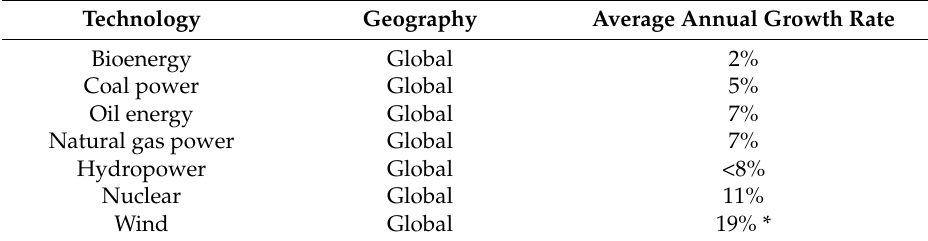
Table 7. Historical growth rates for established energy technologies [17].